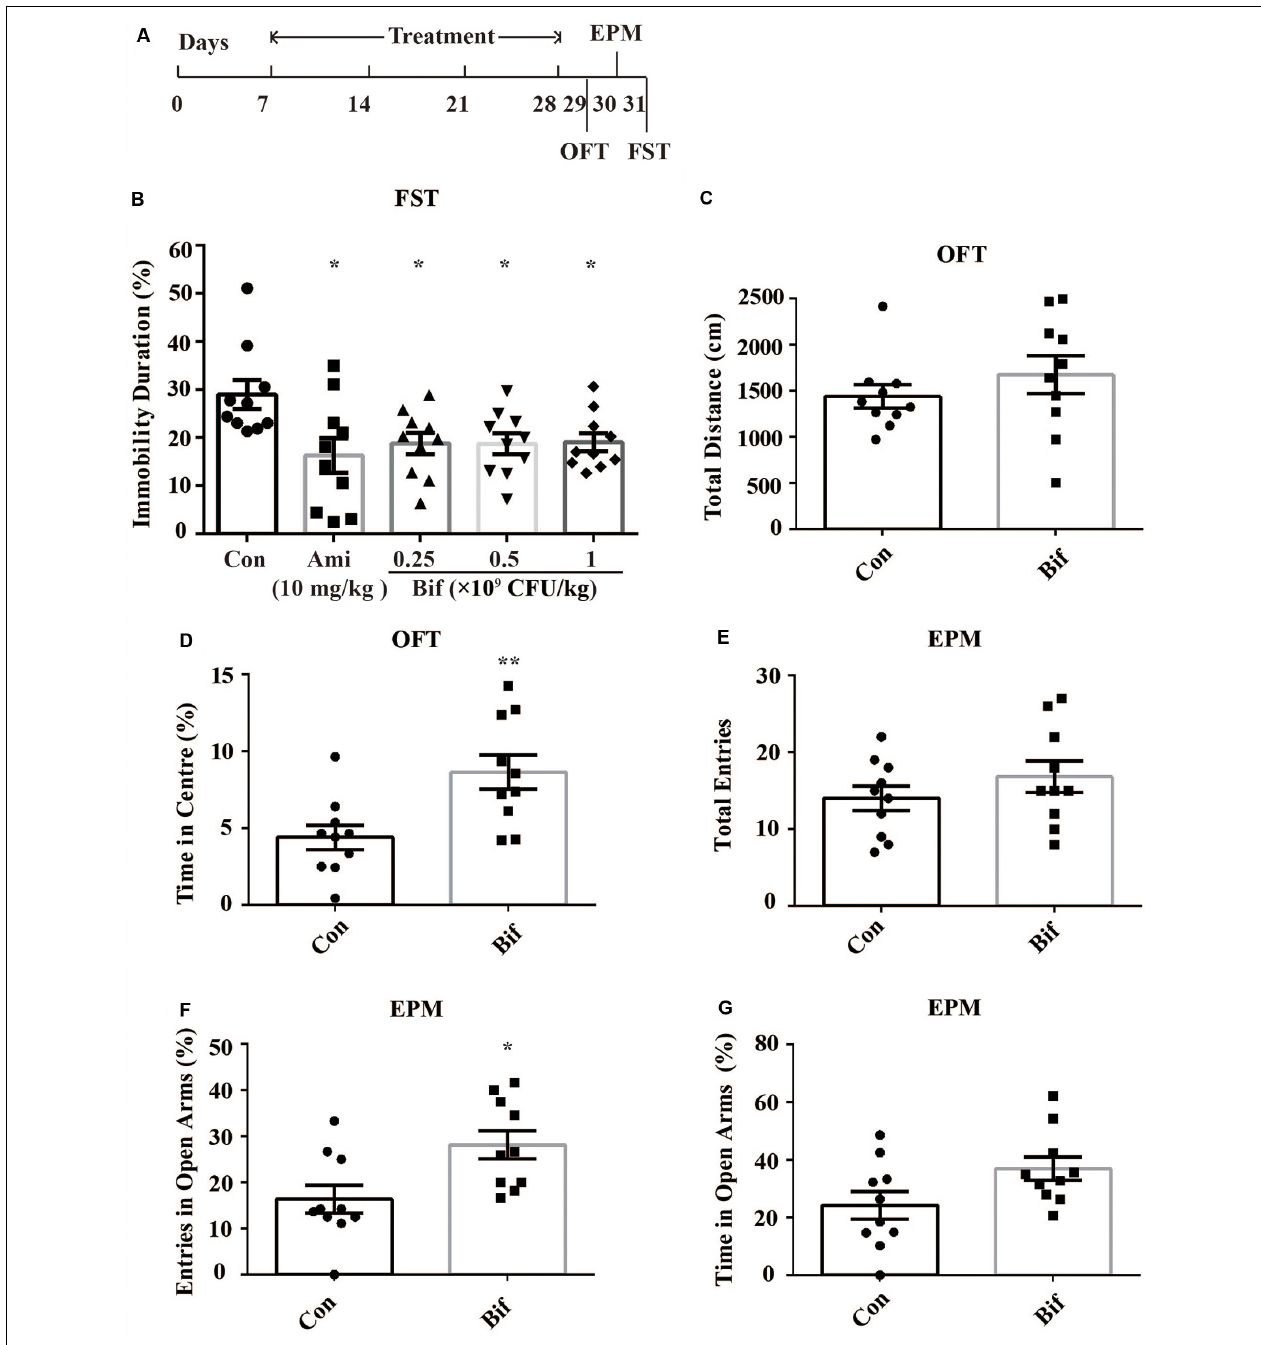
FIGURE 1 | Potential anxiolytic and antidepressant effects of B. adolescentis . The mice in the Con, Ami (10 mg/kg), Bif (0.25 × 10 9 CFU/kg), Bif (0.5 × 10 9 CFU/kg), and Bif (1 × 10 9 CFU/kg) groups were treated with 10 mL/kg distilled water, 10 mg/kg amitriptyline, 0.25 × 10 9 CFU/kg B. adolescentis , 0.5 × 10 9 CFU/kg B. adolescentis , and 1 × 10 9 CFU/kg B. adolescentis , respectively, by gavage for 21 days. (A) The timeline of Experiment 1. (B) The results of the FST showed that the immobility duration was significantly decreased in the Ami (10 mg/kg), Bif (0.25 × 10 9 CFU/kg), Bif (0.5 × 10 9 CFU/kg), and Bif (1 × 10 9 CFU/kg) groups. (C) The OFT showed no significant difference between the control group and the Bif (0.25 × 10 9 CFU/kg) group in the total distance traveled. (D) The OFT showed that the time spent in the center was significantly increased in the Bif (0.25 × 10 9 CFU/kg) group. (E) The EPM test showed no significant difference between the control group and the Bif (0.25 × 10 9 CFU/kg) group in the total number of entries. (F) The number of entries into the open arms of the EPM was significantly increased in the Bif (0.25 × 10 9 CFU/kg) group. (G) The EPM test showed no significant difference between the control group and the Bif (0.25 × 10 9 CFU/kg) group in time spent in the open arms. The data are shown as the mean ± SEM. Student’s t -test was used. ∗ p < 0.05 and ∗∗ p < 0.01 vs. control. Con, Control; Bif, B. adolescentis ; FST, forced swimming test; OFT, open field test; EPM, elevated plus-maze.